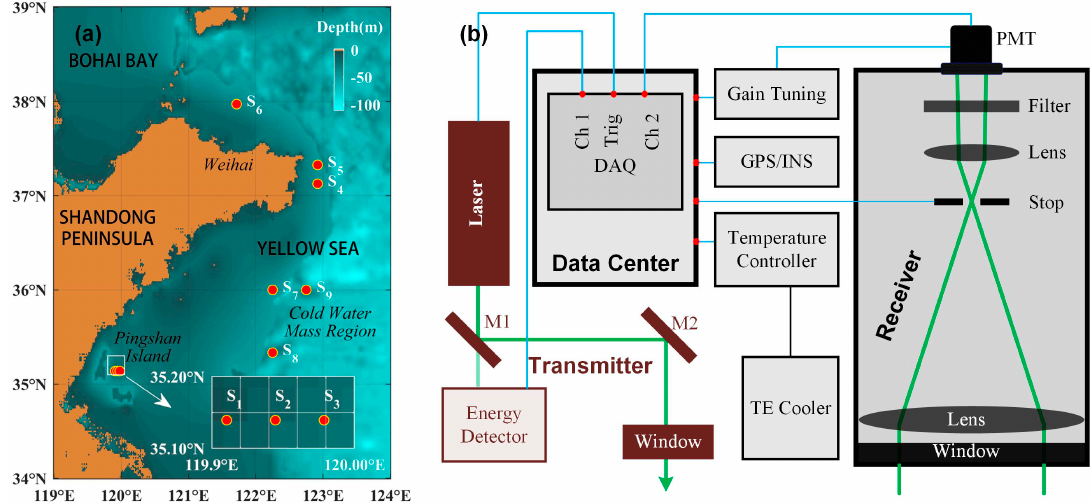
Figure 4. ( a ) The experimental stations and digital topographic data in the Yellow Sea; ( b ) schematic diagram of the oceanic lidar system. The lidar system is mainly composed of three parts: a transmitter, a receiver, and a data center. The transmitter mainly includes a frequency-doubling Q-switched Nd:YAG pulsed laser and a series of reflectors and an optical window. The receiver consists of a telescope, a stop, an interference filter, a collimating lens and a photomultiplier tube (PMT). The data center consists of a high-speed data acquisition card (DAQ) and a series of accessories, e.g., GPS/INS, etc.